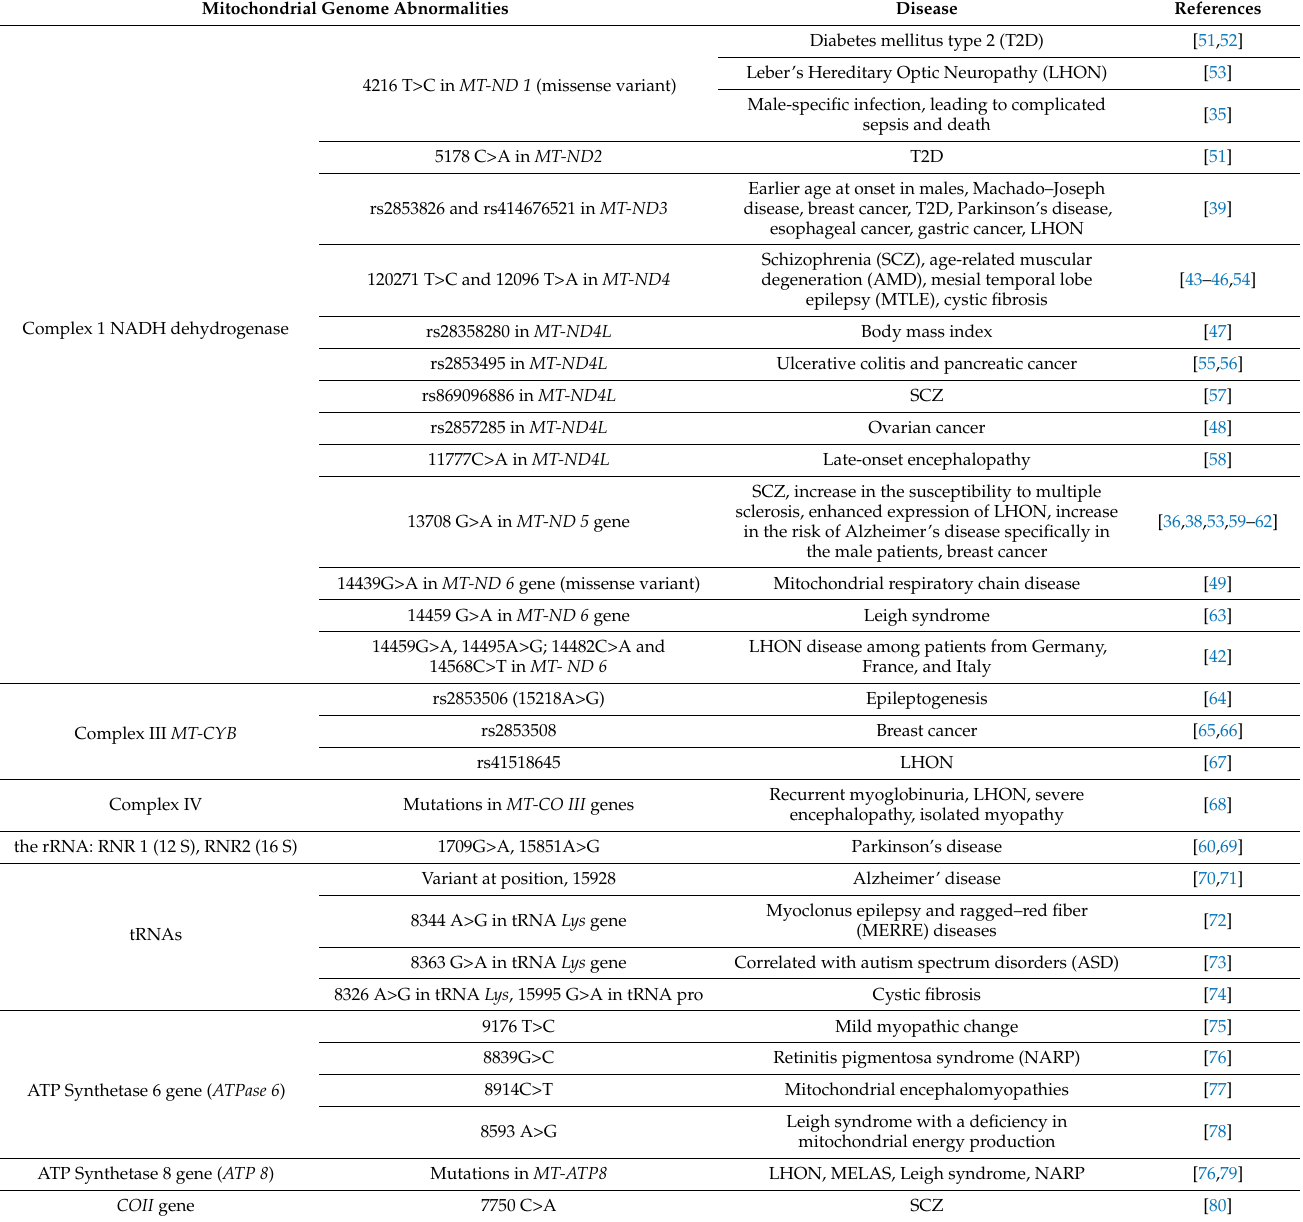
Table 1. Summary of studies reporting different mitochondrial